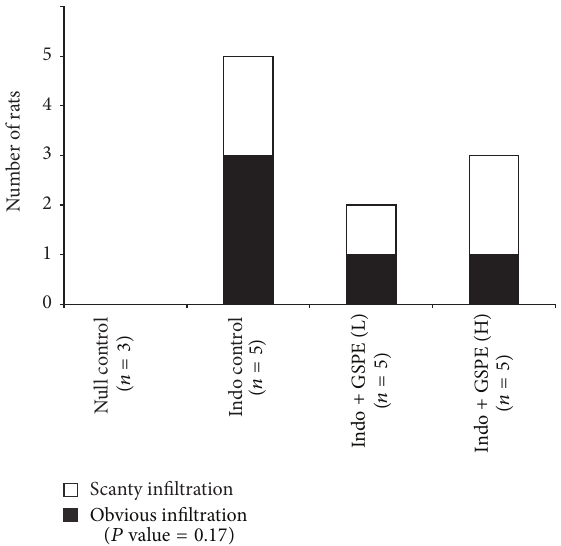
Figure 4: Histologic findings for inflammatory cell infiltration in submucosa. Submucosal inflammatory infiltration was present in all rats of indomethacin control group and about half of the rats in GSPE treated groups ( 𝑃 value = 0.17